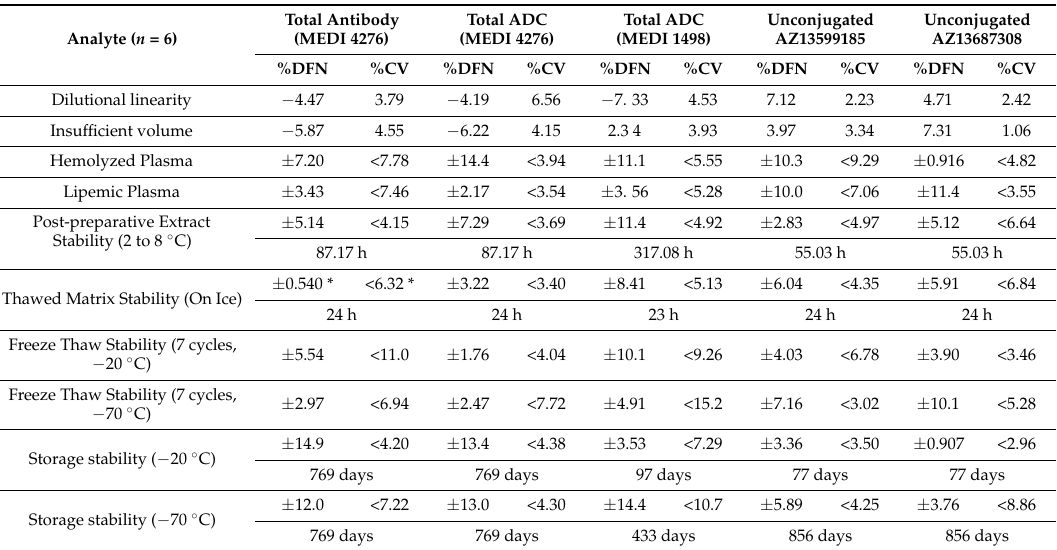
Table 5. Summarized validation and stability